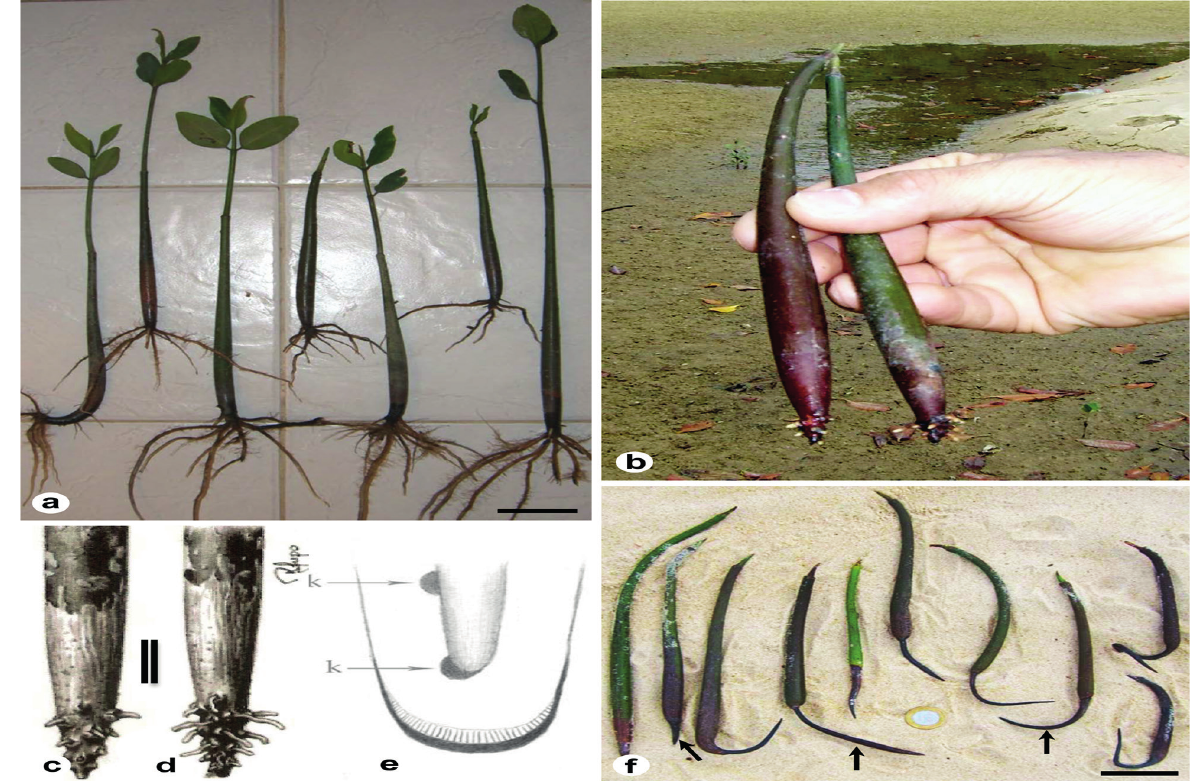
Figure 3 - (a-f): Rhizophora mangle at Porto de galinhas ( a-d ) and at Porto Seguro, Bahia ( f ); - J-shaped plant (on left) and six self-planted (straight) ones. b - d - Self-planted propagules, with the beginning of adventitious root formation; e - Copy of Fig. 25 - i. Plate IX-X from Warming (1883); f - Propagules washed up on the beach at Taperapuã, showing later growth from the lower apex